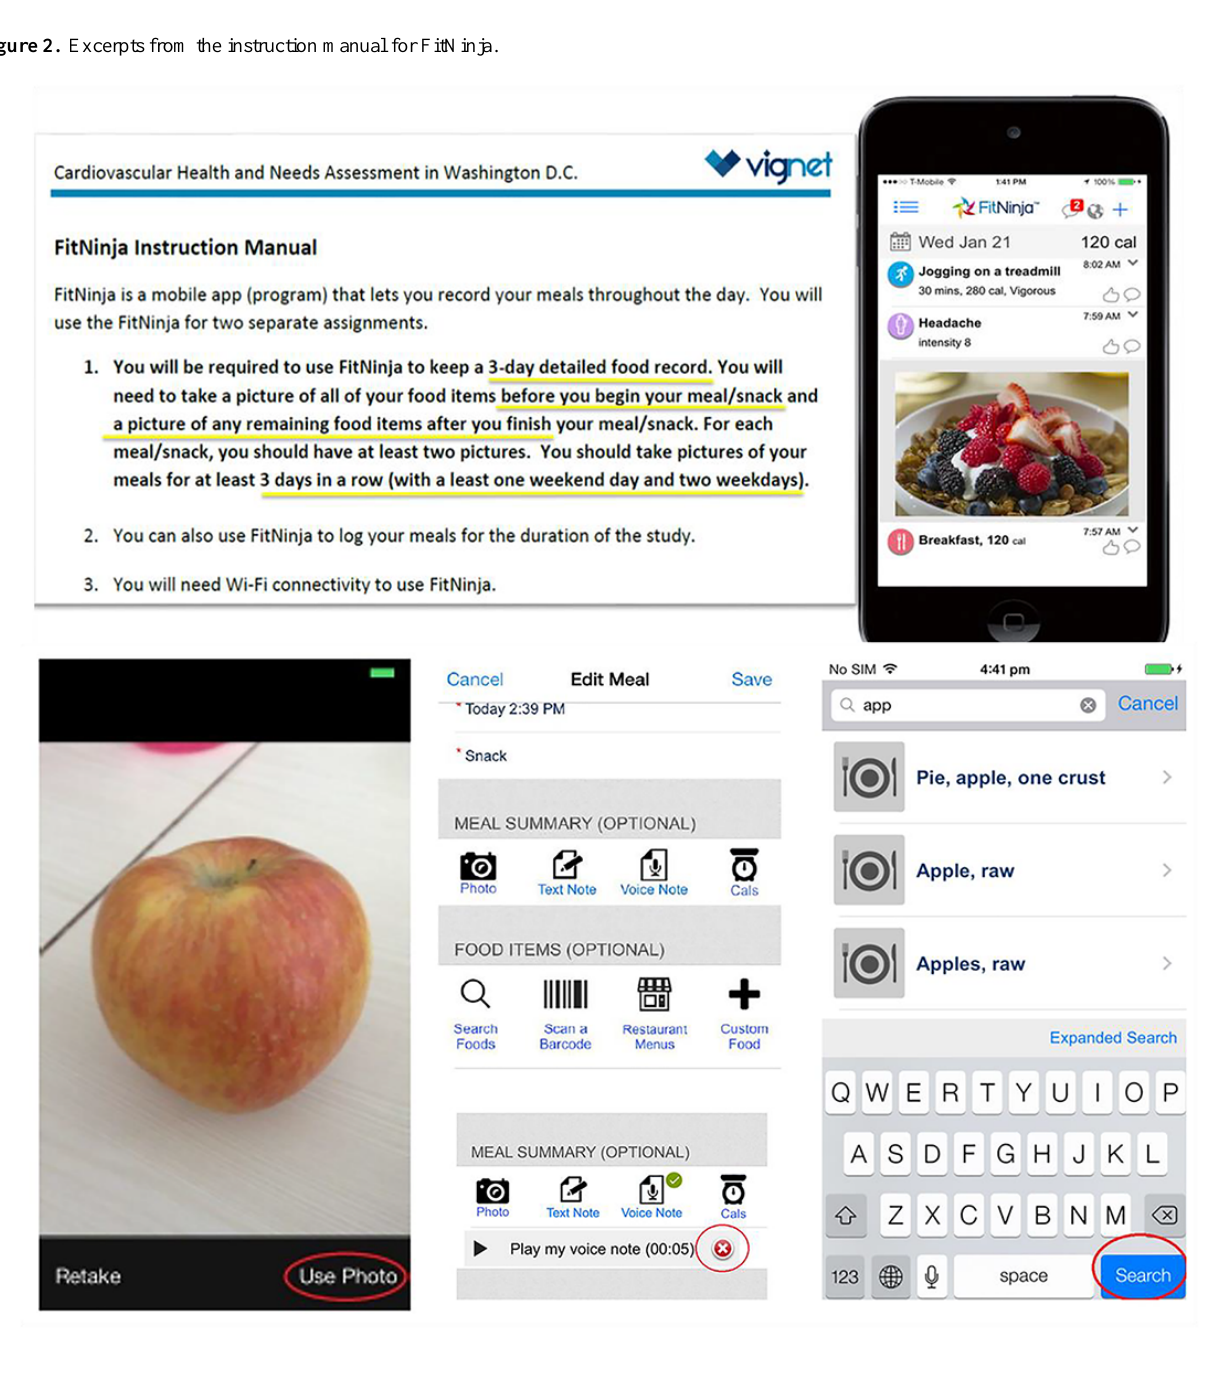
Figure 2. Excerpts from the instruction manual for